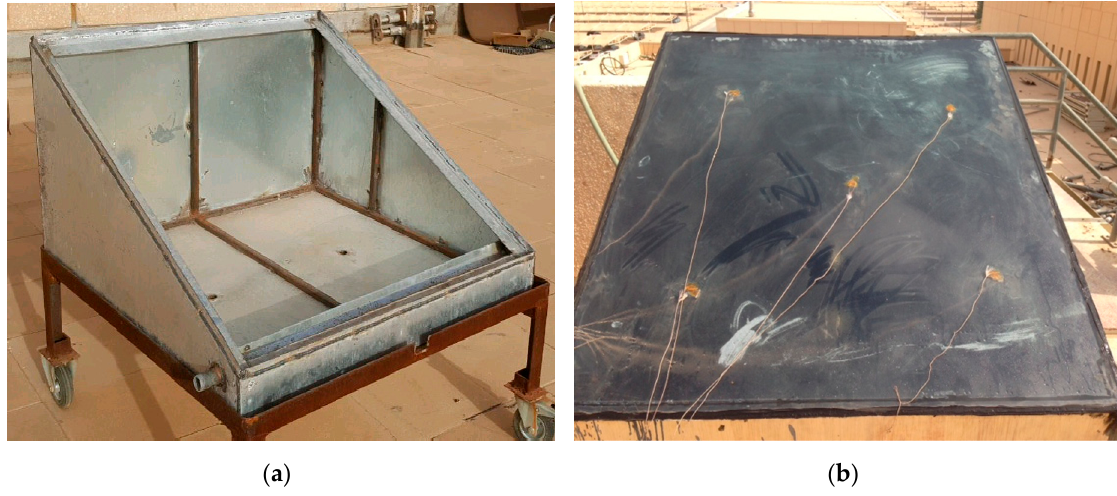
Figure 3. ( a ) Solar still during manufacturing and ( b ) vacuumed solar still during testing.